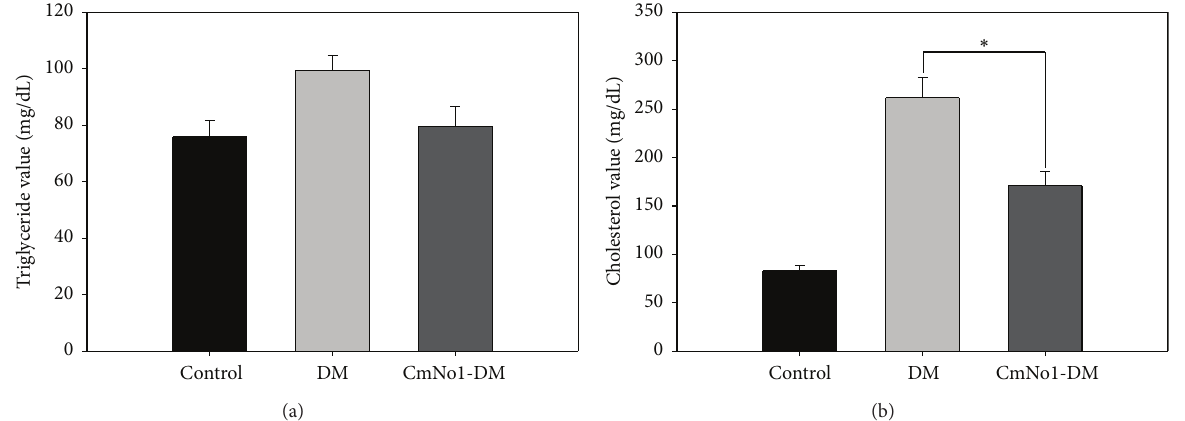
Figure 6: Triglyceride and cholesterol levels. (a) Triglyceride and (b) cholesterol levels were measured in blood samples drawn from control, DM, and CmNo1-treated DM mice after overnight fasting. Data is expressed as the means ± SEM ( 𝑛 = 6 /group). Symbols specify significant difference compared to DM with ∗ indicating 𝑝 < 0.05